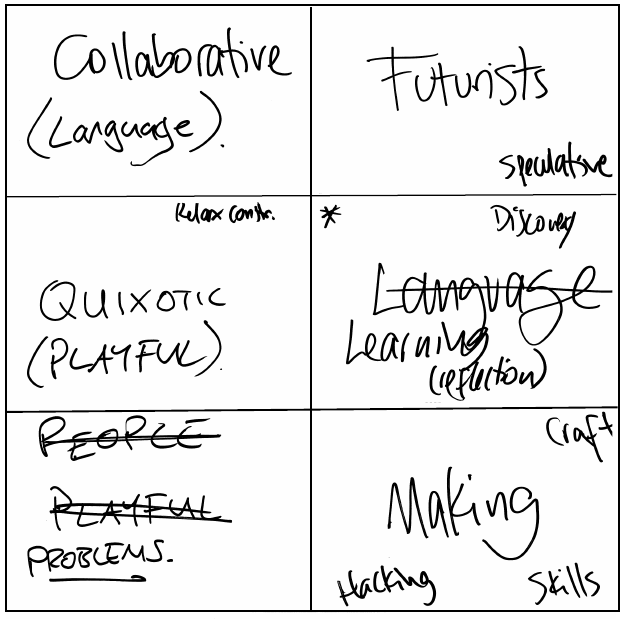
Figure 1. Development Flash